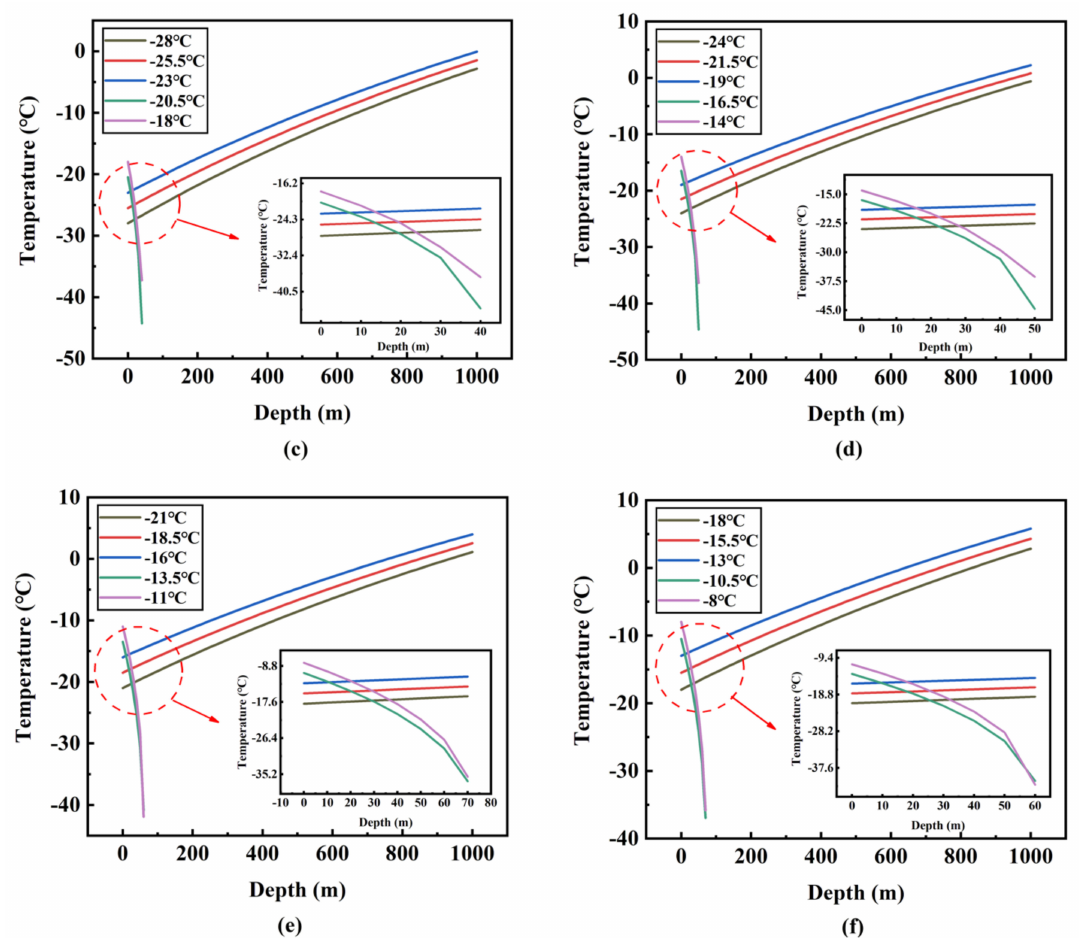
Figure 8. Temperature variation along the pipeline at di ff erent inlet temperatures and di ff erent inlet pressures: ( a ) 14 bar; ( b ) 16 bar; ( c ) 18 bar; ( d ) 20 bar; ( e ) 22 bar; ( f ) 24